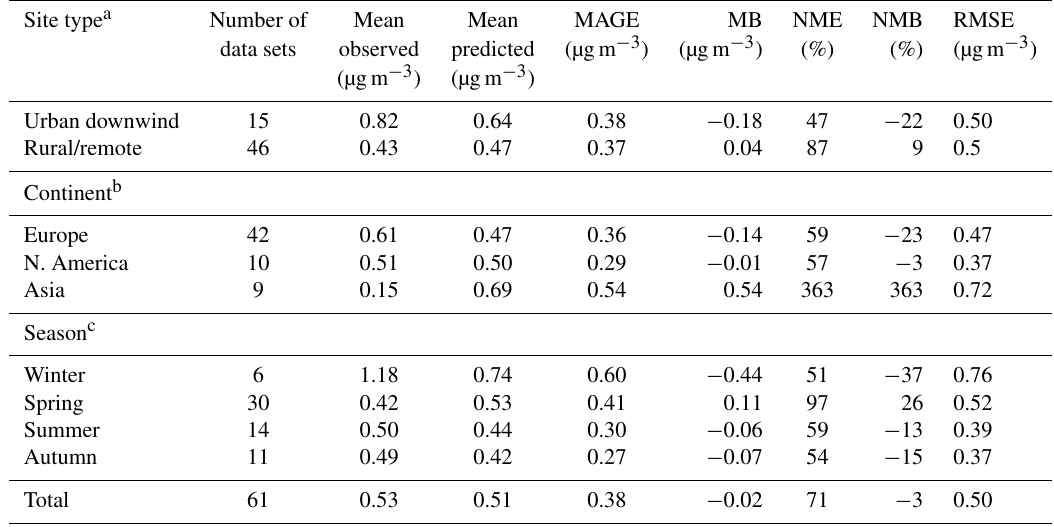
Table 3. Statistical evaluation of EMAC POA (sum of fPOA and bbPOA) against AMS POA (sum of HOA and BBOA) in the Northern Hemisphere during 2001–2010.